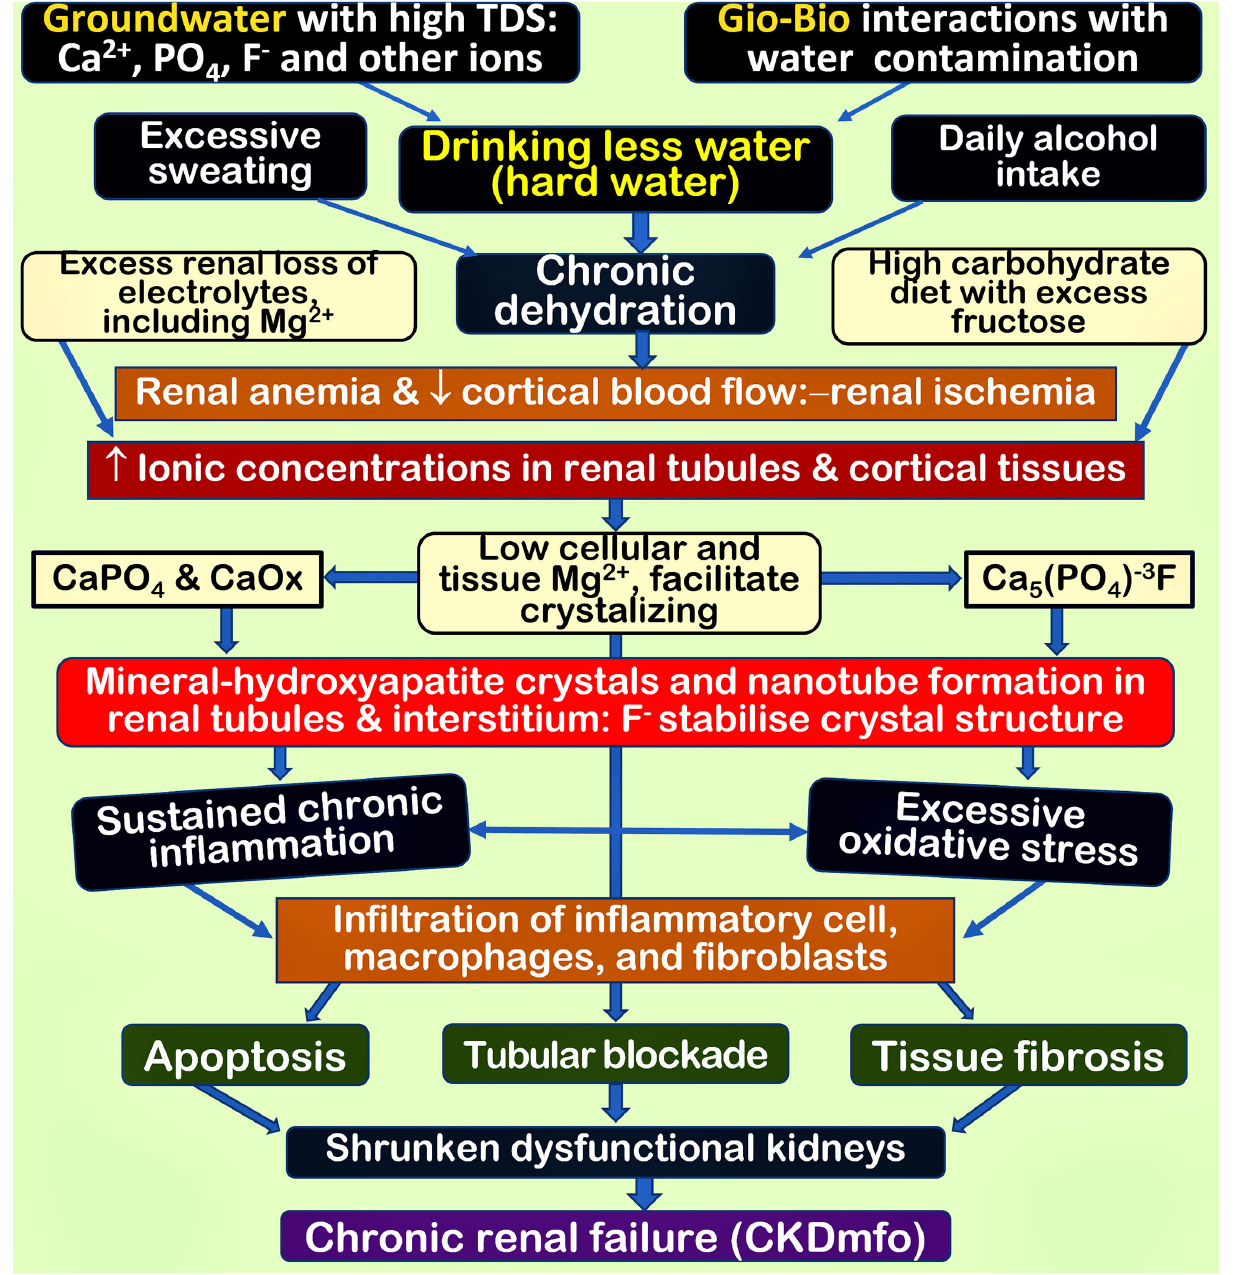
FIGURE 1 | Inter-related mechanisms and multiple pathways leading to the formation of nano-minerals in renal tubular and cortical soft tissues. The fundamental issue is high mineral concentration in the renal cortical fluid and tissues, secondary to ingestion of hard water and chronic dehydration. These multiple factors working together aggravate renal ischemia and anaemia and inflammatory cell infiltration due to nano-mineral precipitation, causing chronic inflammation and oxidative stress. Collectively, these lead to deterioration of renal functions and renal fibrosis, causing irreversible CKD-CTN (CKDmfo) [TDS, total dissolved solids; Ca 2 + and PO 3 − 4 , Mg 2 + , etc.); CaPO 4 , calcium phosphate; CaOx, calcium oxalate; Mg 2 + , magnesium; F − , fluoride]. The figure is modified from Wimalawansa and Dissanayake